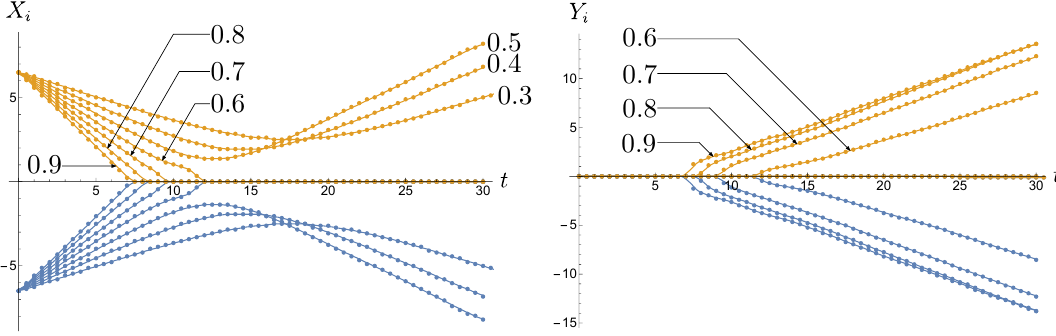
Figure 27 . Trajectories X i ( t ) and Y i ( t ) of two initially orthogonal non-Abelian vortices of type II, scattering head-on with initial velocities u = 0 . 3 , 0 . 4 , · · · , 0 . 9 (marked on the plots for